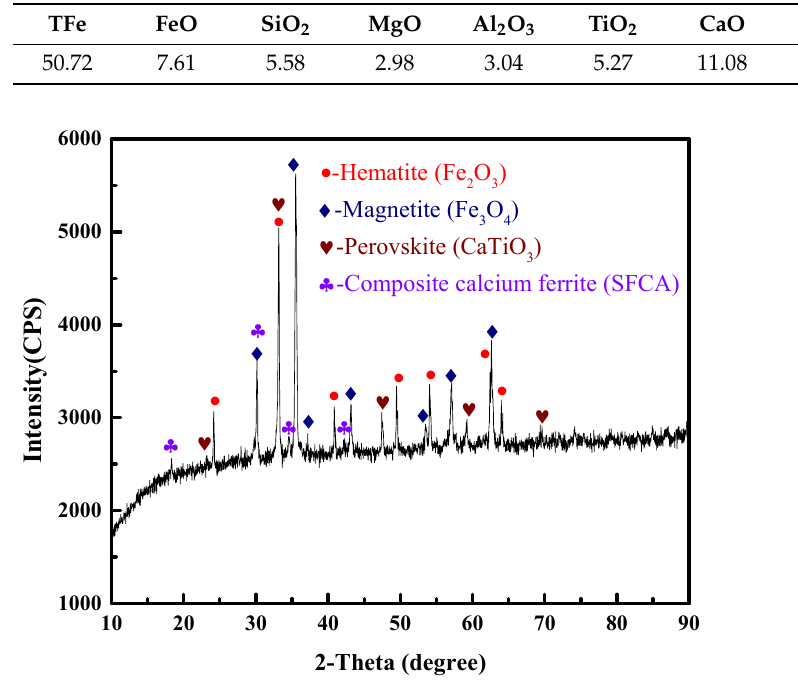
Figure 1. XRD pattern of the VTM sinter.